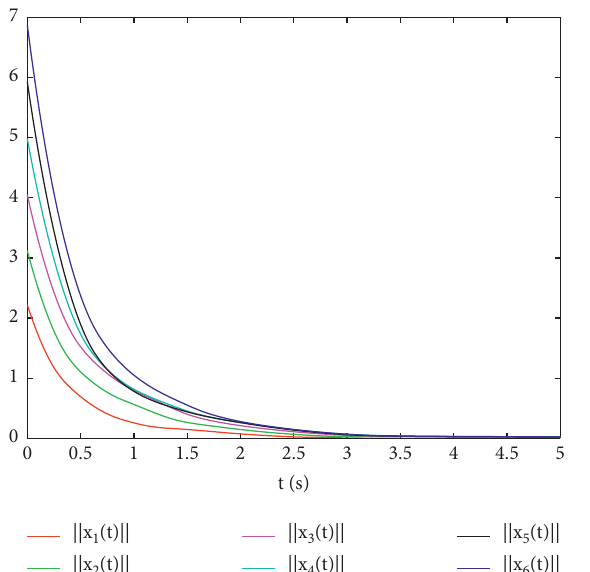
Figure 5: Time evolution of ‖ z